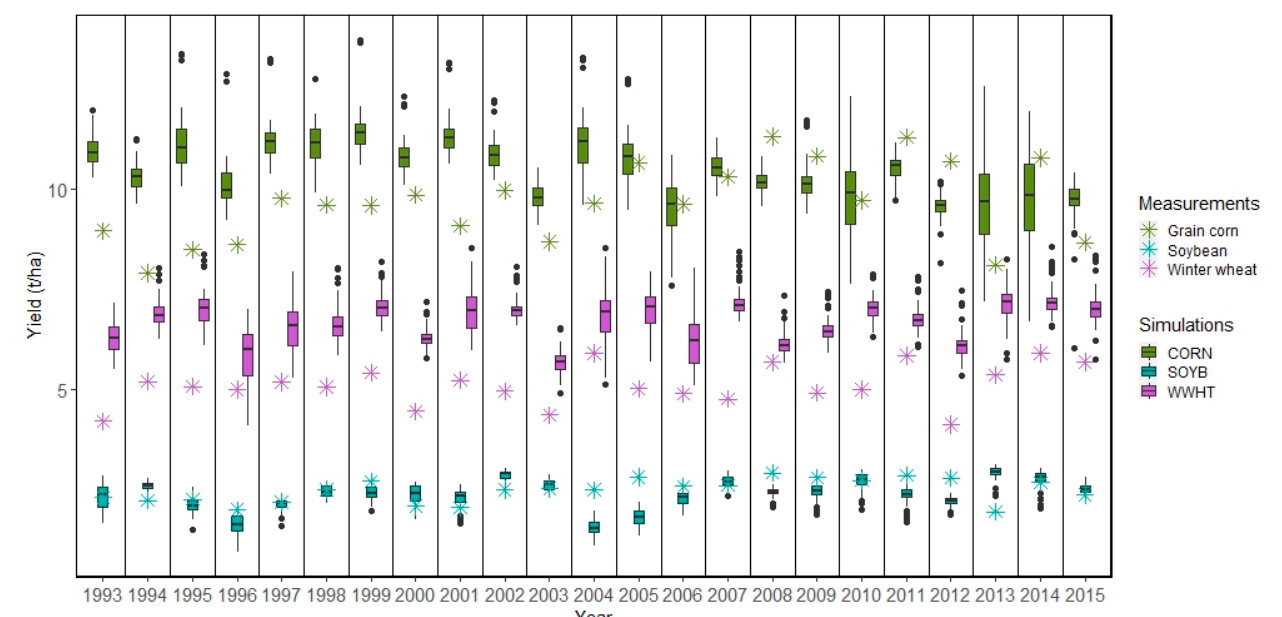
Figure 4. Measured and simulated crop yields at the HRU level in the Melk catchment for M1 setup. The SWAT simulated crops BARL (spring barley), CORN (grain corn), SOYB (soybean), and WWHT (winter wheat) refer to Table S2.